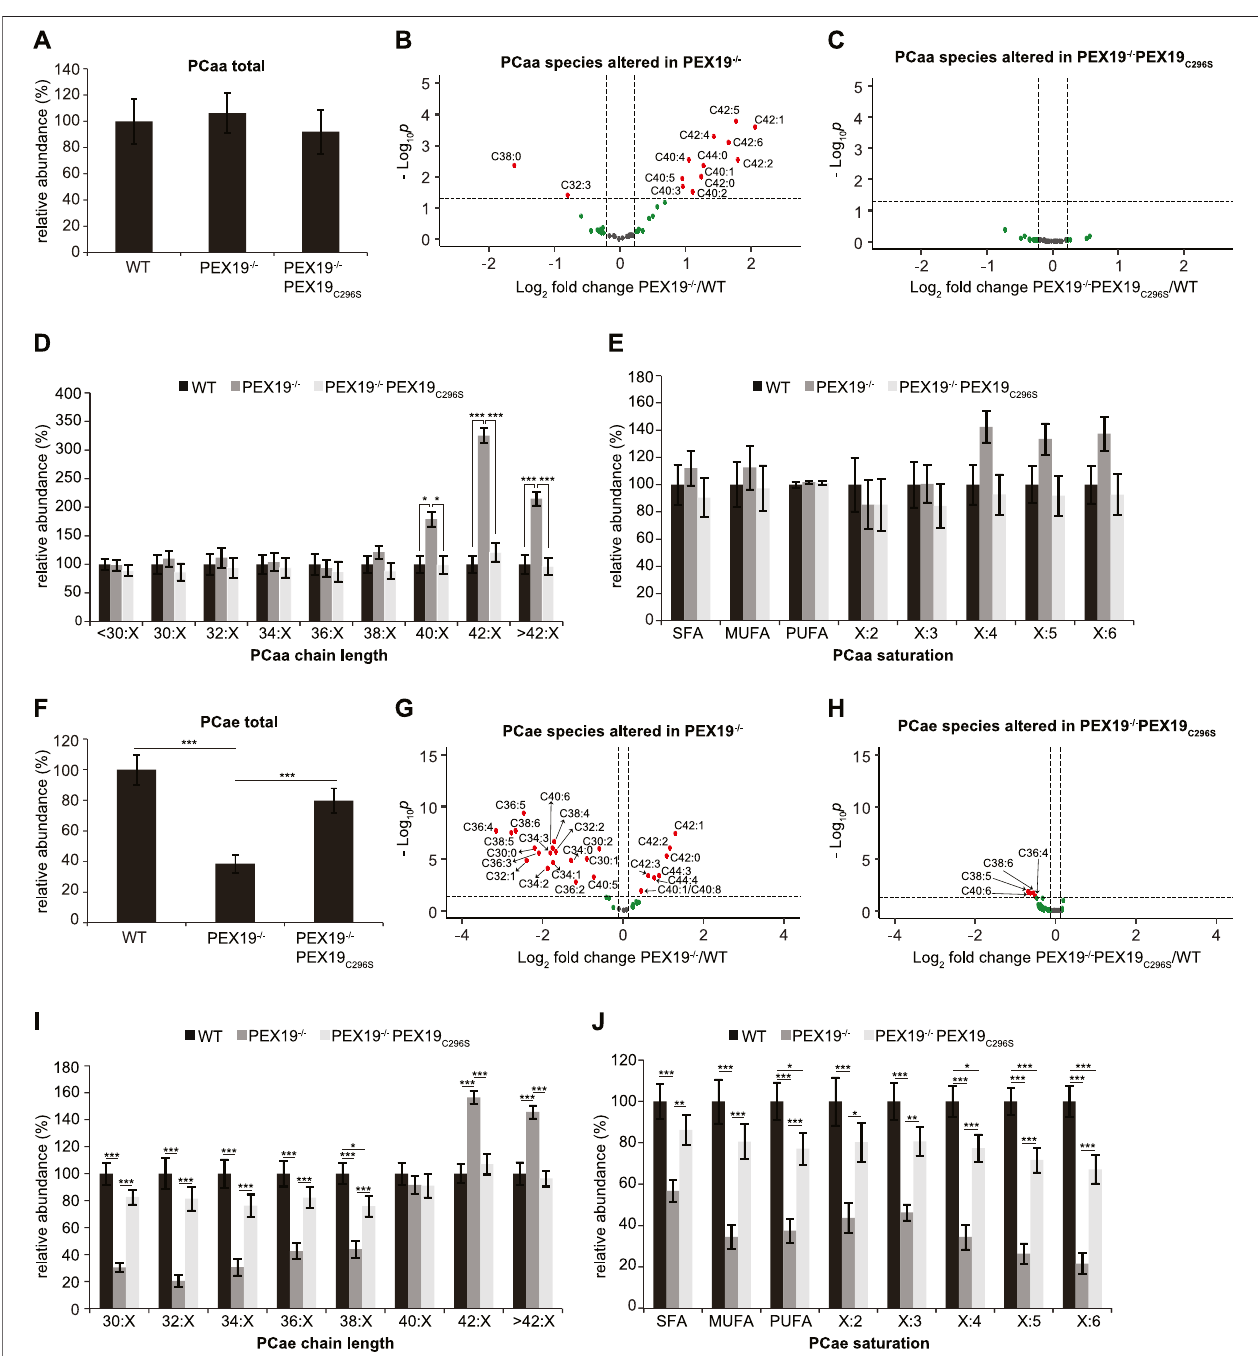
FIGURE2| PEX19 C296S expressioninPEX19knock-outcellsrestoresperoxisomalVLCFAoxidationandetherlipidsynthesis.Shotgun-lipidomicsresultsforester- linkedphosphatidylcholinePCaa (A – E) andether-linkedphosphatidylcholinePCae (F – J) species. (A) BardiagramshowingtherelativeabundanceoftotalPCaaspecies in WT, PEX19 − / − and PEX19 − / − PEX19 C296S cells. ANOVA revealed no signi fi cant changes between the cell lines. (B,C) Volcano plots of PCaa subspecies analyses. 43 PCaa species were analyzed and logarithmically plotted against the p -value (derived from unpaired, two-sided student ’ s t-test) after FDR-correction, illustrating changes in PEX19 − / − cells (B) and PEX19 − / − PEX19 C296S cells (C) compared to WT cells, respectively. Grey dots: lipid species without signi fi cant changes. Green dots: lipid species with a fold change greater than the average SEM but with a p -value > 0.05. Red dots: signi fi cantly altered ( p -value < 0.05) lipid species with a greater fold change than the average SEM. (D) Bar diagram showing the relativeabundance of PCaa species categorized by acyl chain length (sum ofacylchains at sn − 1 and sn − 2 positions). (E) Bar diagram showing the relative abundance of PCaa species categorized by unsaturation of the acyl chains (sum of double bonds in acyl chains at sn − 1 and sn − 2 positions). SFA, saturated fatty acids, MUFA, mono-unsaturated fatty acids, PUFA: poly-unsaturated fatty acids. (F – J) Analogous to (A – E) but illustrating the analyses for 39 ether-linked PCae species instead of PCaa. Error bars indicate SEM and statistical signi fi cance between the groups was determined by an ANOVA followed by Tukey post-hoc test. *,**, *** indicate p -values < 0.05, < 0.01, and < 0.001, respectively. Non-signi fi cant changes are not indicated. For each cell line 11 individual samples were analyzed with three technical replicates each. See also Supplementary Figure S1 .